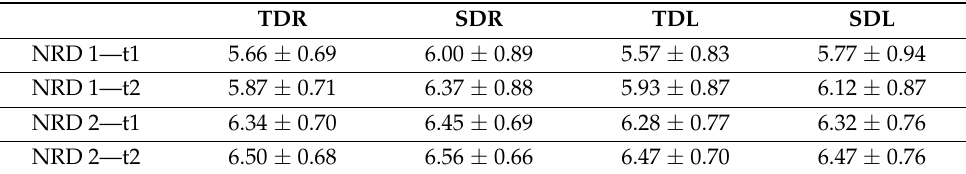
Table 1. Magnetic Resonance Imaging (MRI) measurement values for each assessment. The reported measurements are expressed in mm Standard Deviation (SD). NRD: neuroradiologist; SDL: sagittal diameter left; SDR: sagittal diameter right; t1: first assessment; t2: second assessment; TDL: transverse diameter left; TDR: transverse diameter right.